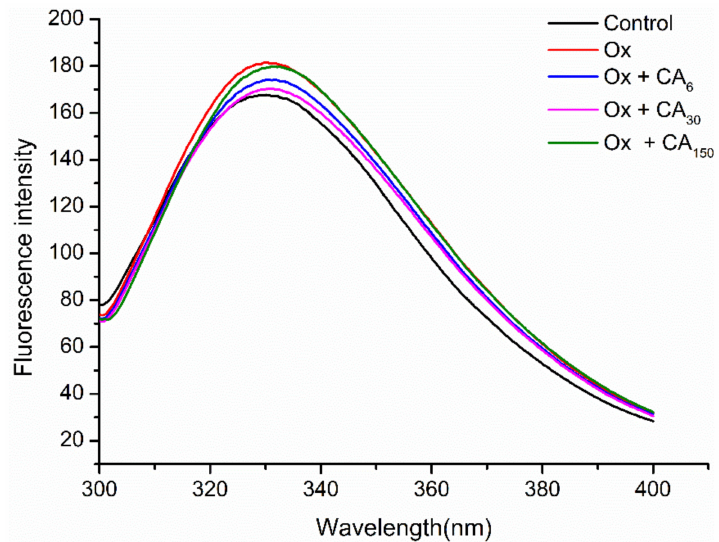
Figure 1. Tryptophan endogenous fluorescence of oxidized myofibrillar protein (MP) from Coregonus peled in chlorogenic acid (CA). Control: nonoxidized; Ox: oxidized; Ox + CA 6 , Ox + CA 30 , and Ox + CA 150 : oxidized in the presence of CA at 6, 30, and 150 µ M / g protein,